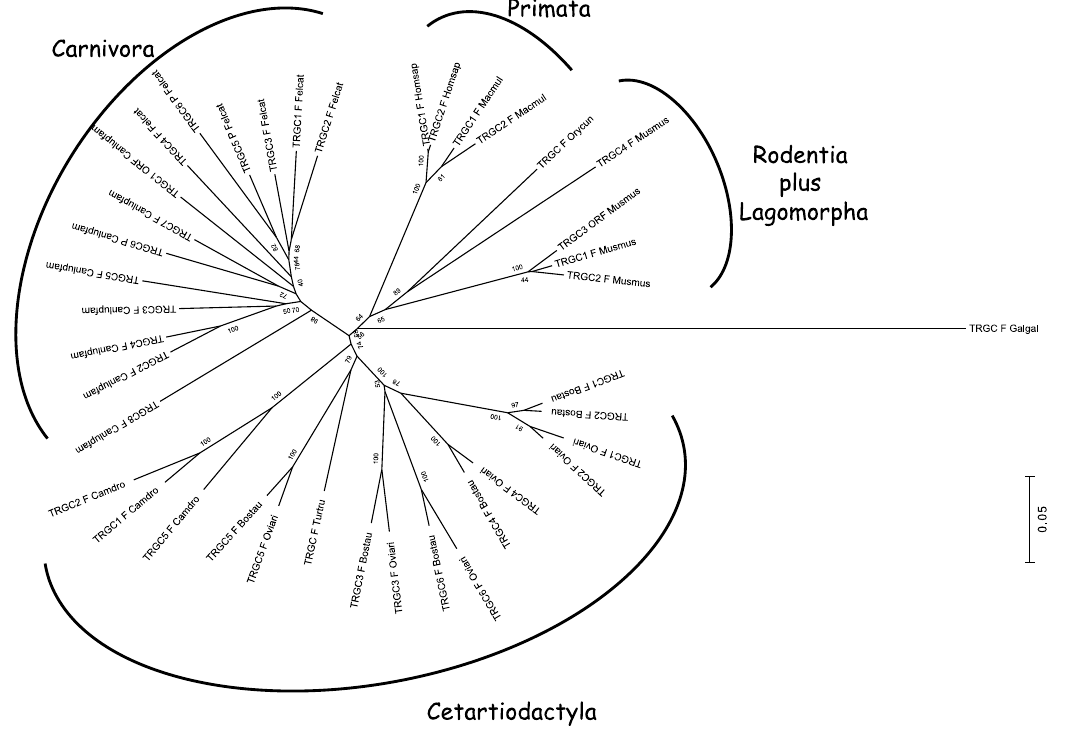
Figure 5. Phylogenetic relationships of the eutherian mammalian TRGC genes. The TRGC coding nucleotide sequences from the different eutherian mammals were combined in the same alignment. The chicken (Galgal) TRGC gene was used as outgroup [66]. Multiple alignments of the gene sequences were carried out using the MUSCLE program [111]. The evolutionary analyses were conducted in MEGA7 [112]. We used the neighbor-joining (NJ) method to reconstruct the phylogenetic tree [113]. The percentage of replicate trees in which the associated taxa clustered together in the bootstrap test (100 replicates) is shown next to the branches [114]. The trees are drawn to scale, with branch lengths in the same units as those of the evolutionary distances used to infer the phylogenetic trees. The evolutionary distances were computed using the p-distance method [115] and the units are the number of base di ff erences per site. The analysis involved 38 nucleotide sequences. All positions containing gaps and missing data were eliminated. There were a total of 324 positions in the final dataset. The IMGT six-letter standardized abbreviations for species (Homsap (human), Musmus (mouse), Felcat (cat), Bostau (bovine), Oviari (sheep), Camdro (dromedary), Turtru (dolphin), Orycun (rabbit)) and nine-letter standardized abbreviations for subspecies (Canlupfam, dog) taxa are used.